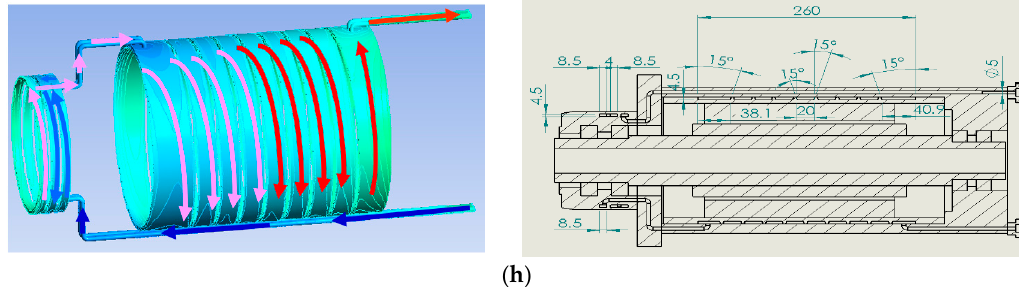
Figure 3. Specific dimensions of cooling channel types. ( a ) Helical channel type with single-turn front bearing channel (unit: mm); ( b ) Helical channel type with paralleling front bearing channel (unit: mm); ( c ) Pair path split cooling (separate cooling oil of bearing and motor) (unit: mm); ( d ) Single-turn paralleling channel type with paralleling front bearing channel (unit: mm); ( e ) Double-turn paralleling channel type with paralleling front bearing channel (unit: mm); ( f ) Axial channel type with paralleling front bearing channel (unit: mm); ( g ) Axial channel type increase in dimension with paralleling front bearing channel (unit: mm); ( h ) Trapezoidal channel type with paralleling front bearing channel (unit: mm).